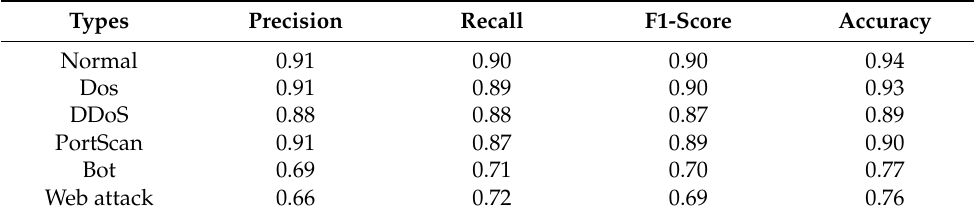
Table 7. Classification results of G-TIAG.